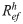
Estimation of Model PMAL in Period 3 (October/2004—September/2008).(a) observed incidence (O) and adjusted i (E), (b) m3/m, (c) Refh (h) and Refm (m), and (d) Ref=Refh×Refm.